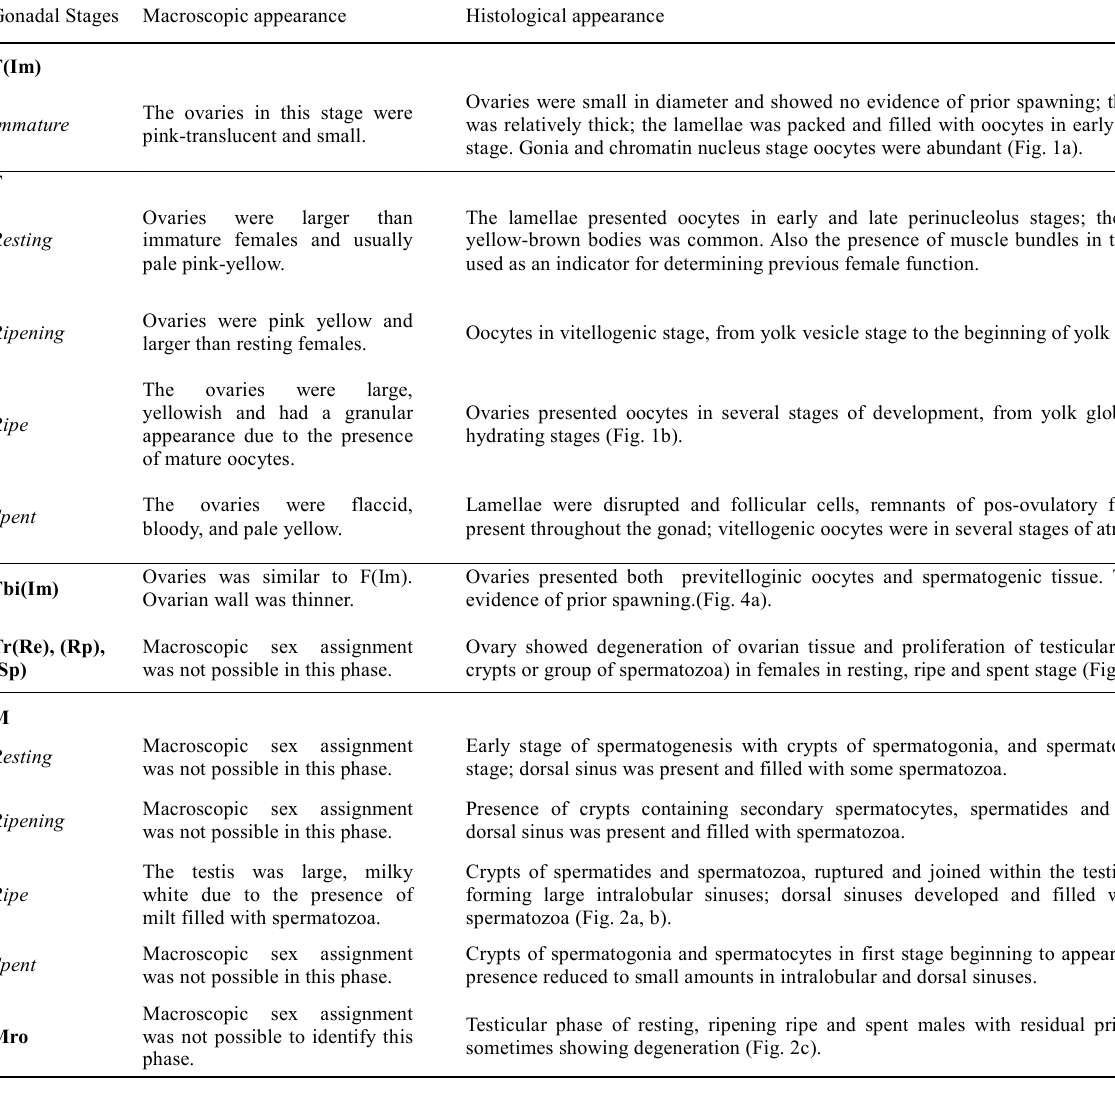
Table 2. Description of gonadal stages of Alphestes afer. F (Im): immature female; F: female; Fbi(Im): immature bisexual phase of female; Tr(Re): transitional resting; Tr(Rp): transitional ripe; Tr(Sp): transitional spent; M: male; Mro: male with residual